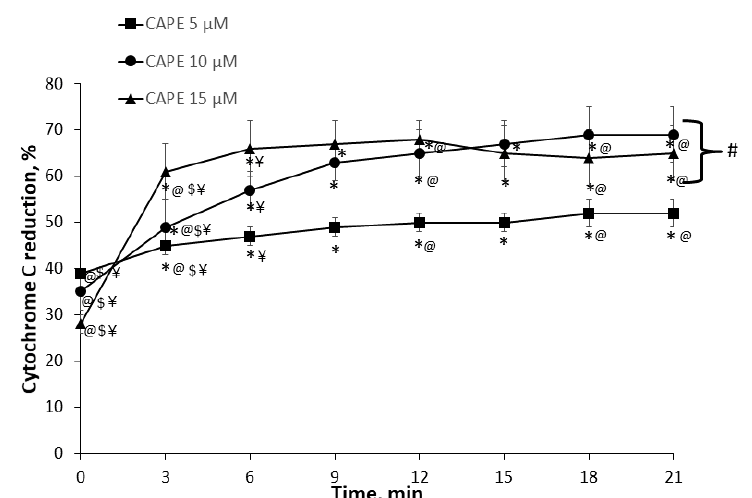
Figure 2. Effect of caffeic acid phenethyl ester on cytochrome c reduction. * p < 0.05 vs. time at the 0 min point; @ p < 0.05 vs. time at the 6 min point; $ p < 0.05 vs. time at the 9 min point; ¥ p < 0.05 vs. time at the 21 min point; # p < 0.05 vs. CAPE at a 5 µM concentration . Two-way ANOVA followed by a Fisher ’s LSD post hoc test were used to compare the effects.